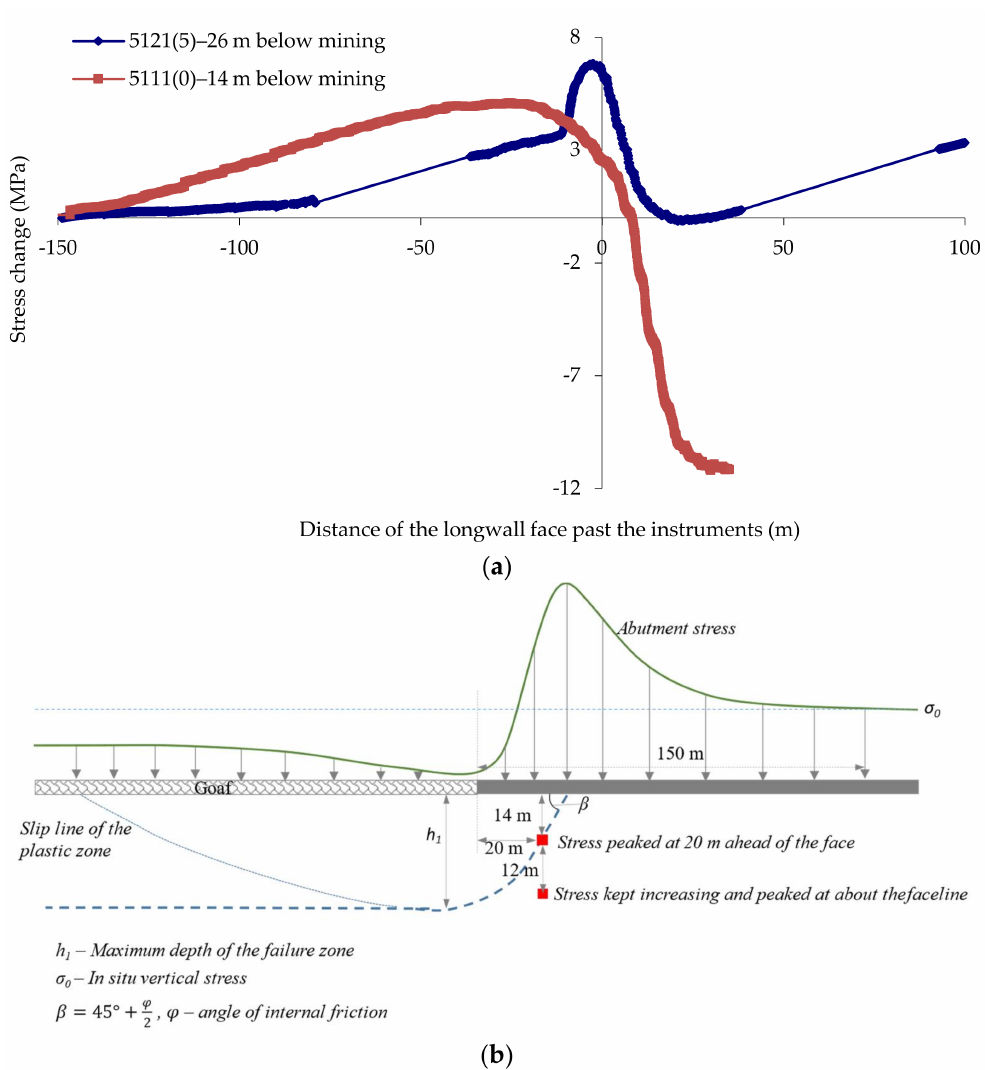
Figure 7. ( a ) Comparison of monitored stress change at LW 5121(5) and LW 5111(0). ( b ) Interpreted stress change and strata failure zone in the floor strata (the profile of the floor failure zone is based on Zhang and Liu